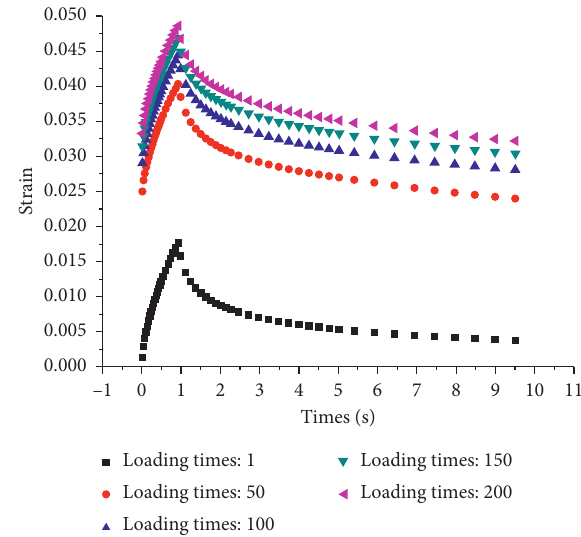
Figure 3: Creep-recovery response of